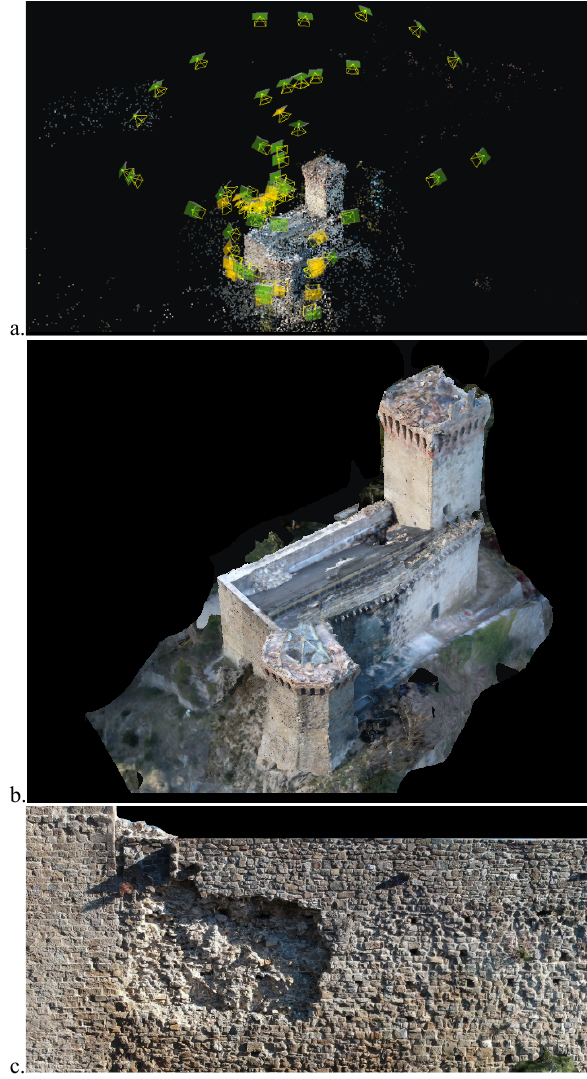
Figure 7. Photogrammetric reconstruction of the stronghold: a) image alignment; b) final mesh and c) detail of the orthophoto